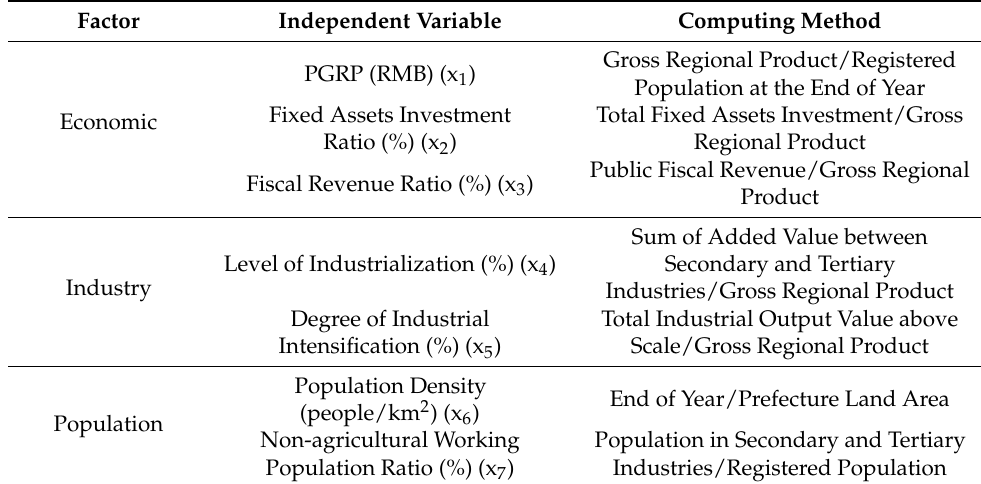
Table 2. Index selection of influencing